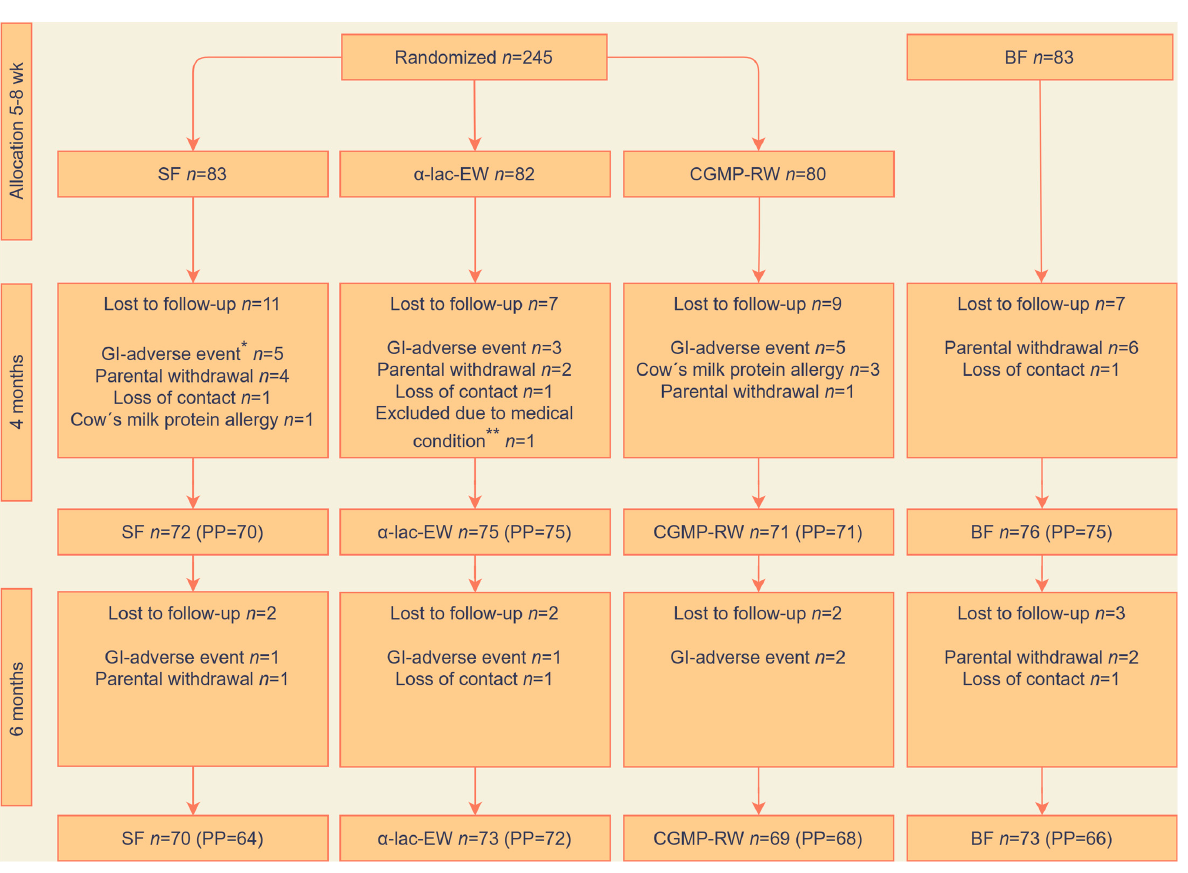
Figure 1. Study flowchart. Randomization, allocation and follow-up in intention-to-treat and per protocol (PP) populations. SF, standard formula; α -lac-EW, experimental formula with α -lactalbumin- enriched whey; CGMP-RW, experimental formula with reduced CGMP whey; BF, breast-fed. Reasons for lost to follow-up: * Gastrointestinal adverse events, such as vomiting, stomach ache, flatulence or constipation. ** Congenital genetic disease affecting